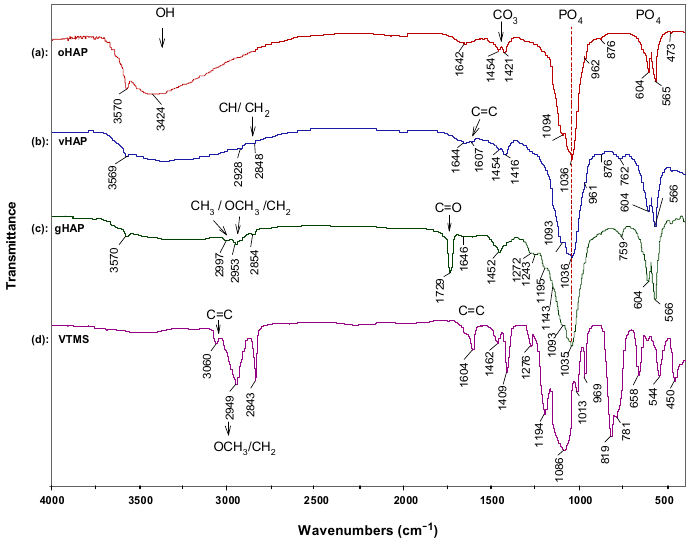
of VTMS per 1 g of HAP). In the range of 400–700 ◦ C, the degradation of oHAP was still observed. Furthermore, the proposed degradation reaction in Figure 2d shows that vHAP degrades into pure HAP, SiO 2 and gases derived from VTMS (with a molecular formula equivalent to OC 2 H 6 , 46.07 mol/g). It can be proposed that the difference between the weight losses from 400 ◦ C to 700 ◦ C of the vHAP and oHAP can be assigned to the degraded organic part (OC 2 H 6 ) [37]. As shown in Figure 3, this value is calculated as 1.48% − 0.82% = 0.66%. Theoretically, the molar amount of VTMS grafting on the surfaces of the HAPs can be calculated as Equation (1) with a value of 0.143 mmol/g (of HAP) or a percentage of VTMS grafting of 1.52 wt.%, as in Equation (2), where 106.15 is molecular mass of (OH) 3 SiCH = CH 2 [38]. In comparison with the VTMS loading of 1.0 mmol/g, the VTMS grafting content of 0.143 mmol/g was quite low. This means that the loading dose of the VTMS should be further increased.